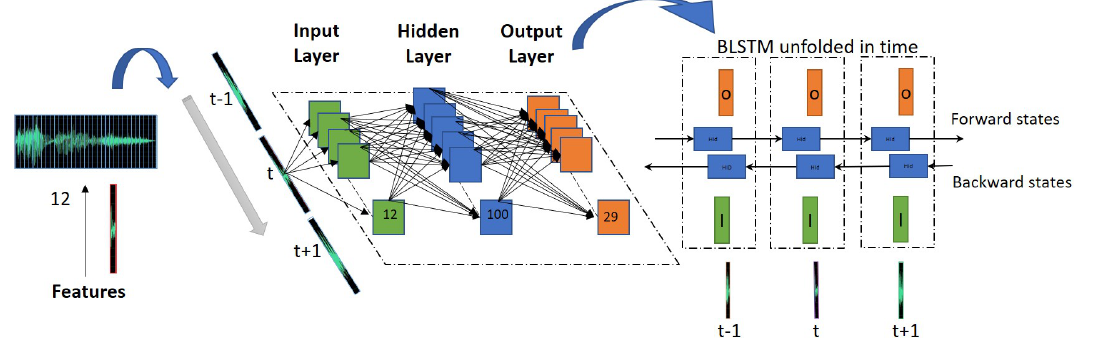
Figure 8. Bidirectional long short-term memory (BLSTM)